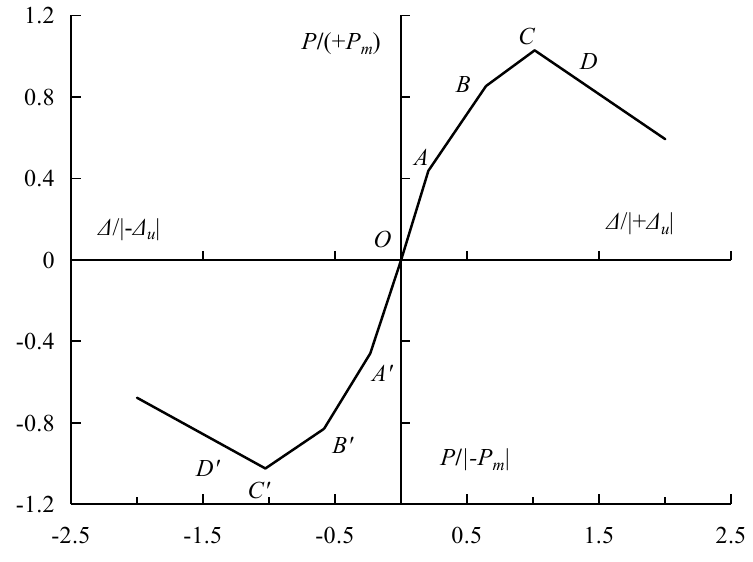
Figure 21. Skeleton curve model with four-line. Table 8. Linear equation and stiffness of each stage in skeleton curve model of interior joint.